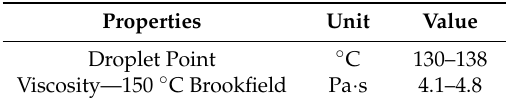
Table 3. Properties of H7686.